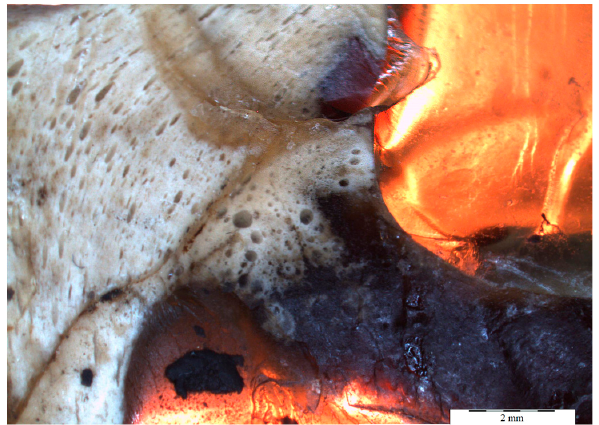
Figure 4. Stereoscopic photo of the contact zone between resin varieties II and III.